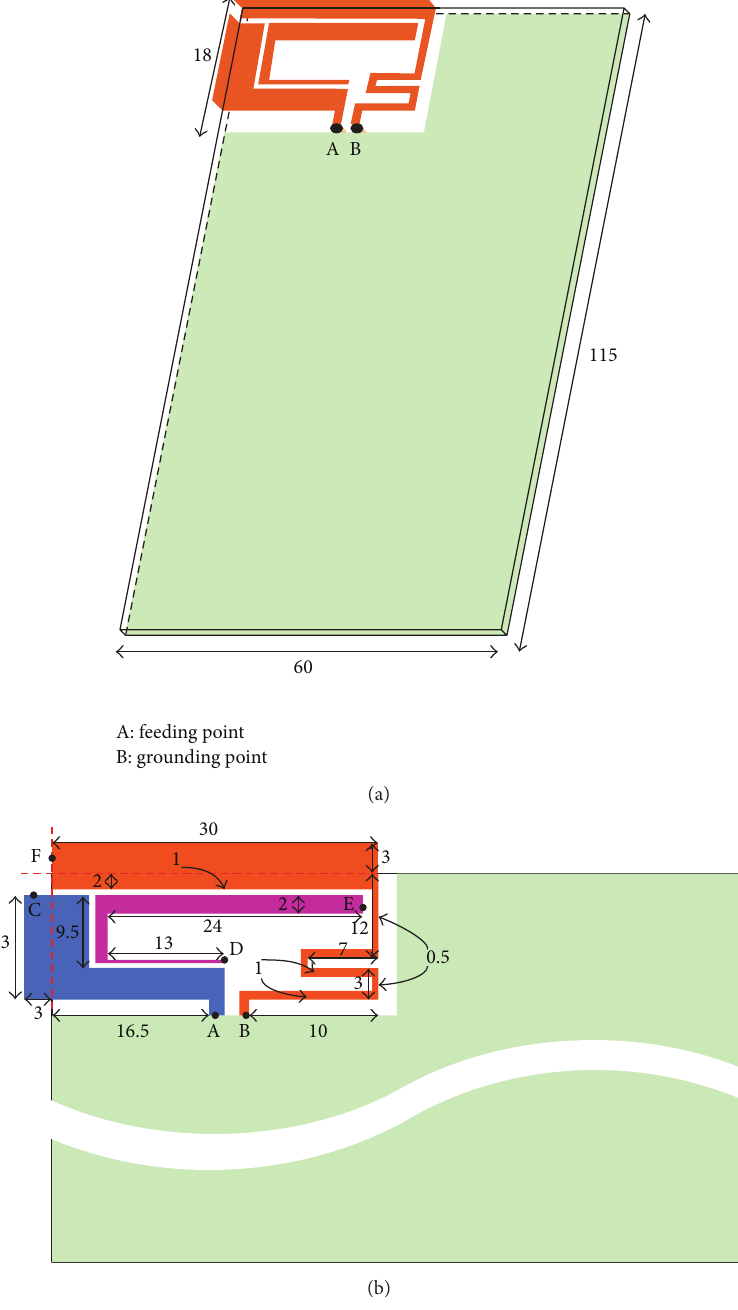
Figure 1: (a) Geometry of the proposed antenna. (b) Dimensions of the metal pattern of the antenna (unit: millimeters).